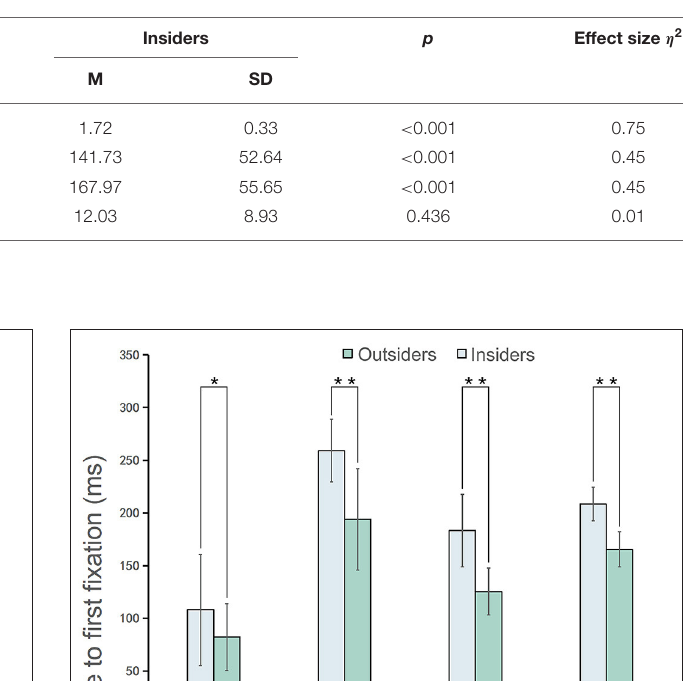
TABLE 1 | Results for outsiders and insiders: the mean landscape preference scores with associated paired t -test analysis; and mean values of the eye movement metrics, with their non-parametric Mann–Whitney U tests.